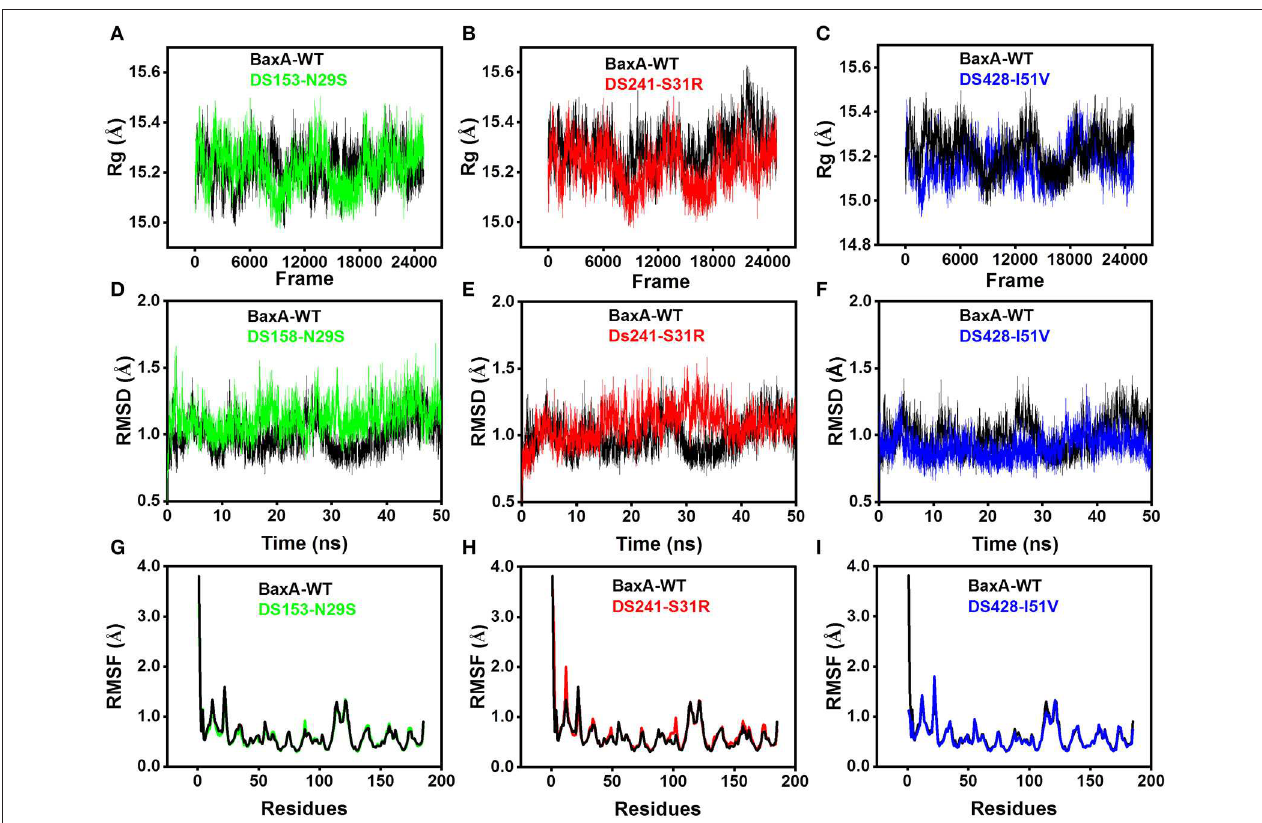
FIGURE 4 | Superposed plots for radius of gyration (Rg), RMSD and RMSF of BaxA and three mutants. (A–C) , Superposed Rg graph. (D–F) Superposed RMSD graph. (G–I) Superposed RMSF graph. BaxA-WT (black), DS153-N29S (green), DS241-S31R (red), and DS428-I51V